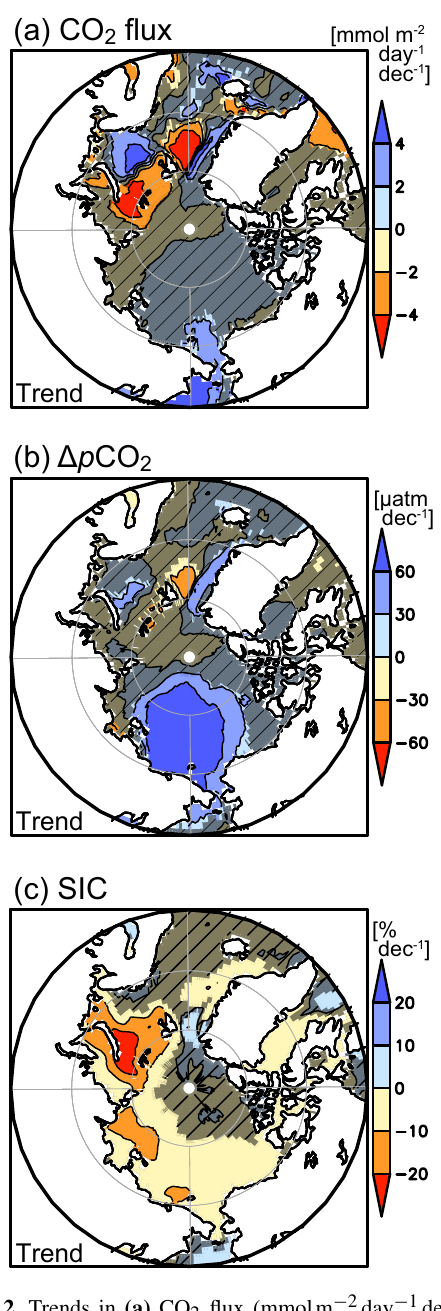
Figure 12. Trends in (a) CO 2 flux (mmolm − 2 day − 1 decade − 1 ), (b) (cid:49)p CO 2 (µatmdecade − 1 ), and (c) SIC (%decade − 1 ). Darker hatched areas represent values in grids where trend values were less than the uncertainty, estimated as described in the